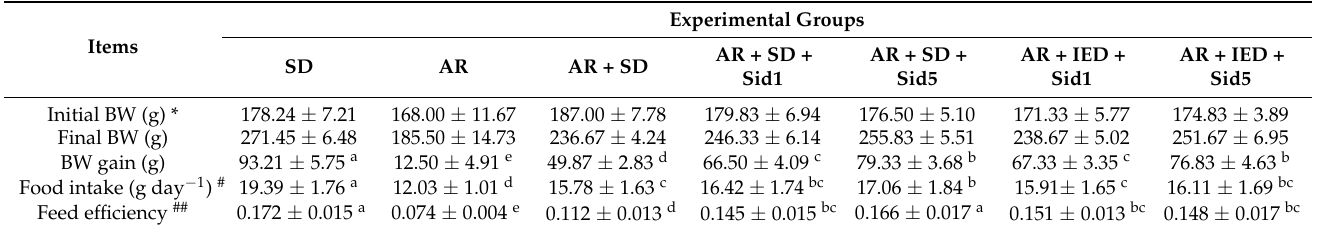
Table 2. Growth parameters, food intake, and feed efficiency of rats fed different formulated experi- mental diets with an intraperitoneal injection of Sid after a recovery period of 4 weeks ( n =